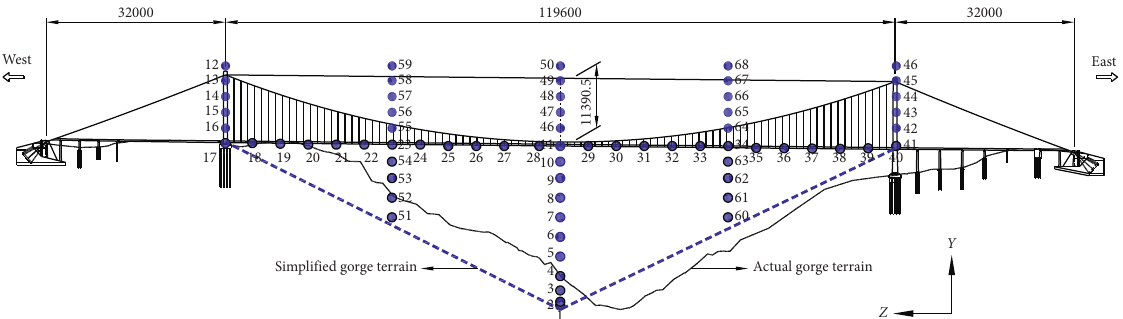
Figure 3: Bridge site and the monitoring points (unit: cm).